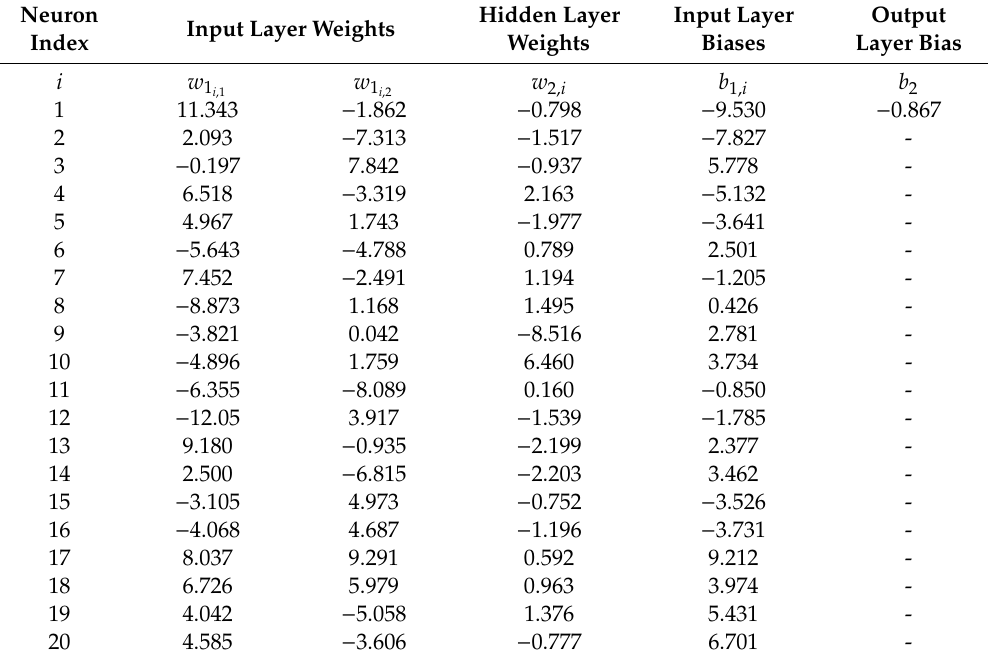
Table 7. The optimized coe ffi cients for estimating the normalized n n in Equation (24).